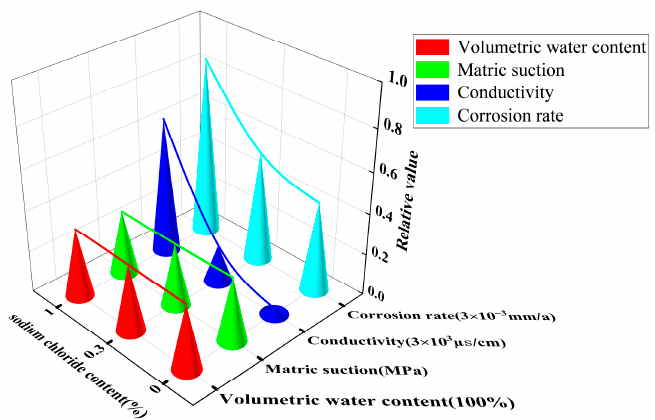
Figure 16. Variation trend of corrosion rate of X70 steel sheet samples with soil volumetric water content, electrical conductivity, and matrix suction at 90 days’ age at height position 12 # of soil column with different NaCl content.